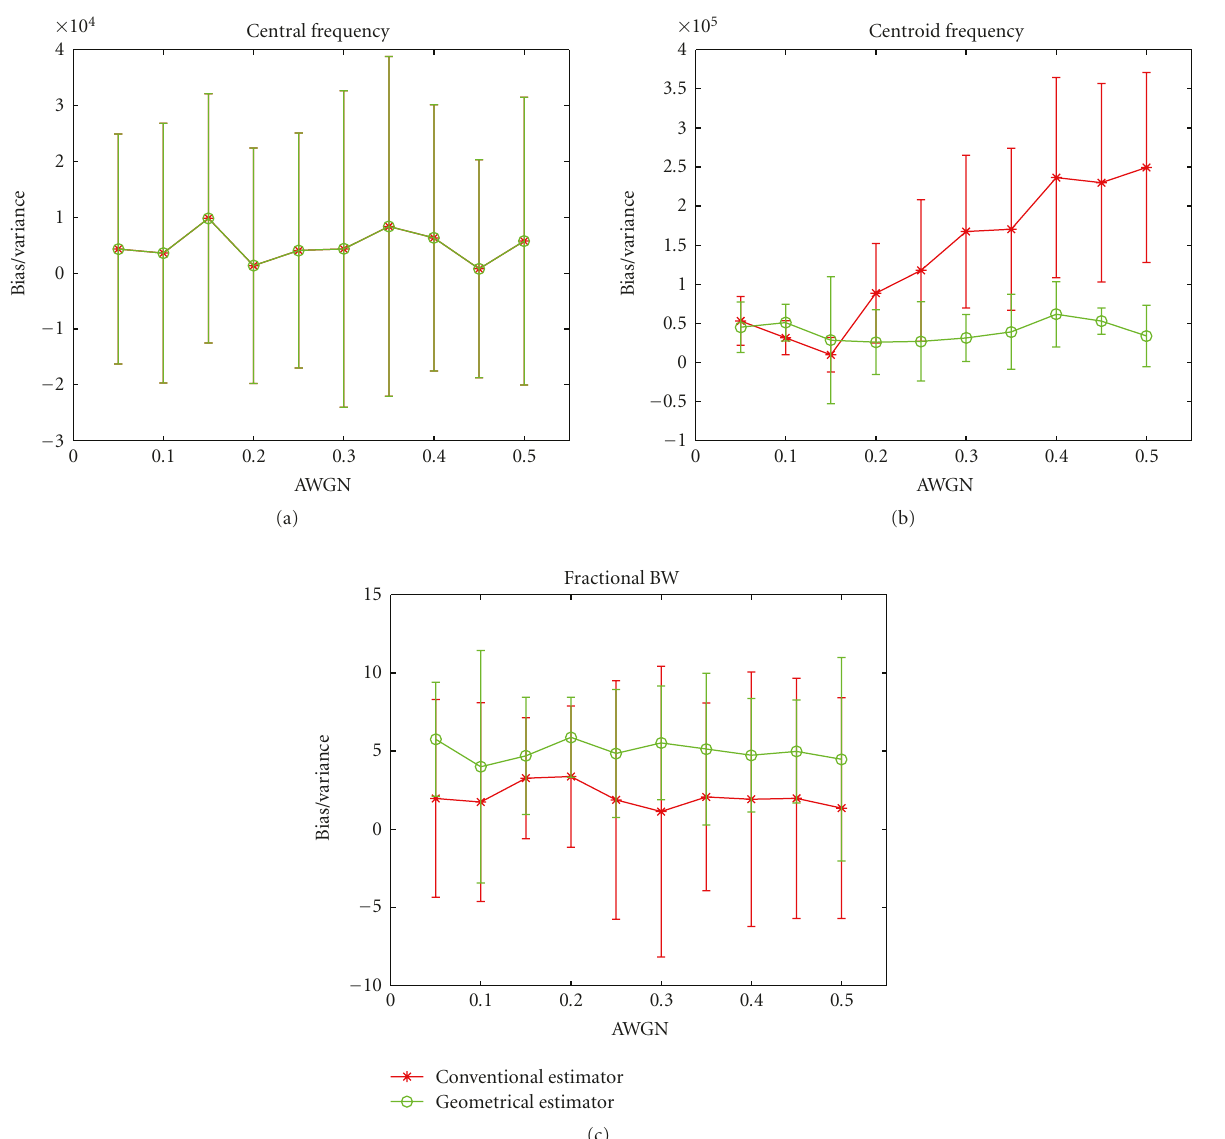
Figure 7: Central Frequency, Centroid Frequency, and Fractional BandWidth operators variance and deviation from the theoretical result. Simulation parameters for LTV were mean scatterer diameter D = 1 . 5 mm, AWGN of variance varying from 0.05 to 0.5. Bias (marker “ ∗ ” or “o”), and variance (vertical